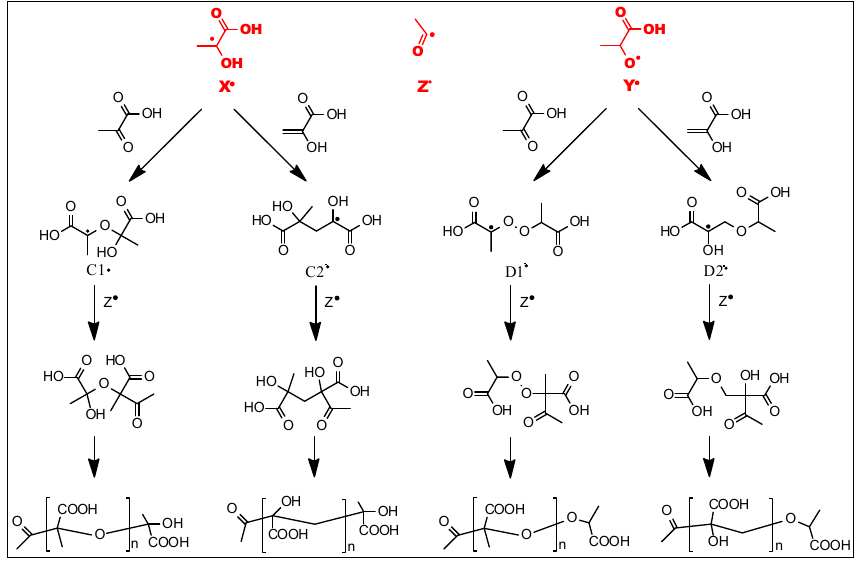
1137 Scheme B. Propagation steps of the pyruvic acid oligomerization mechanism after Guzman et al. (2006b, 2007) and Rincon et al. (2009, 1138 2010). See text for details. 1139 1140